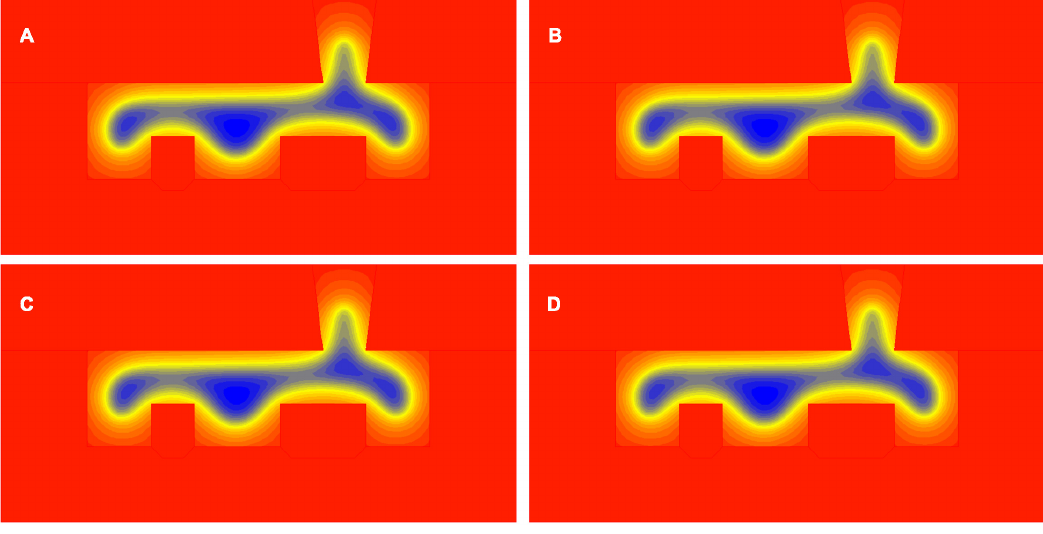
Figure 13. Distribution of solid phase fraction in casting domain (red color—liquid state, blue color—solid state). Four combination of the time integration schemes ( A ) I − I m , ( B ) E − E m , ( C ) E − I m , ( D ) I − E m for multiplication factor m =